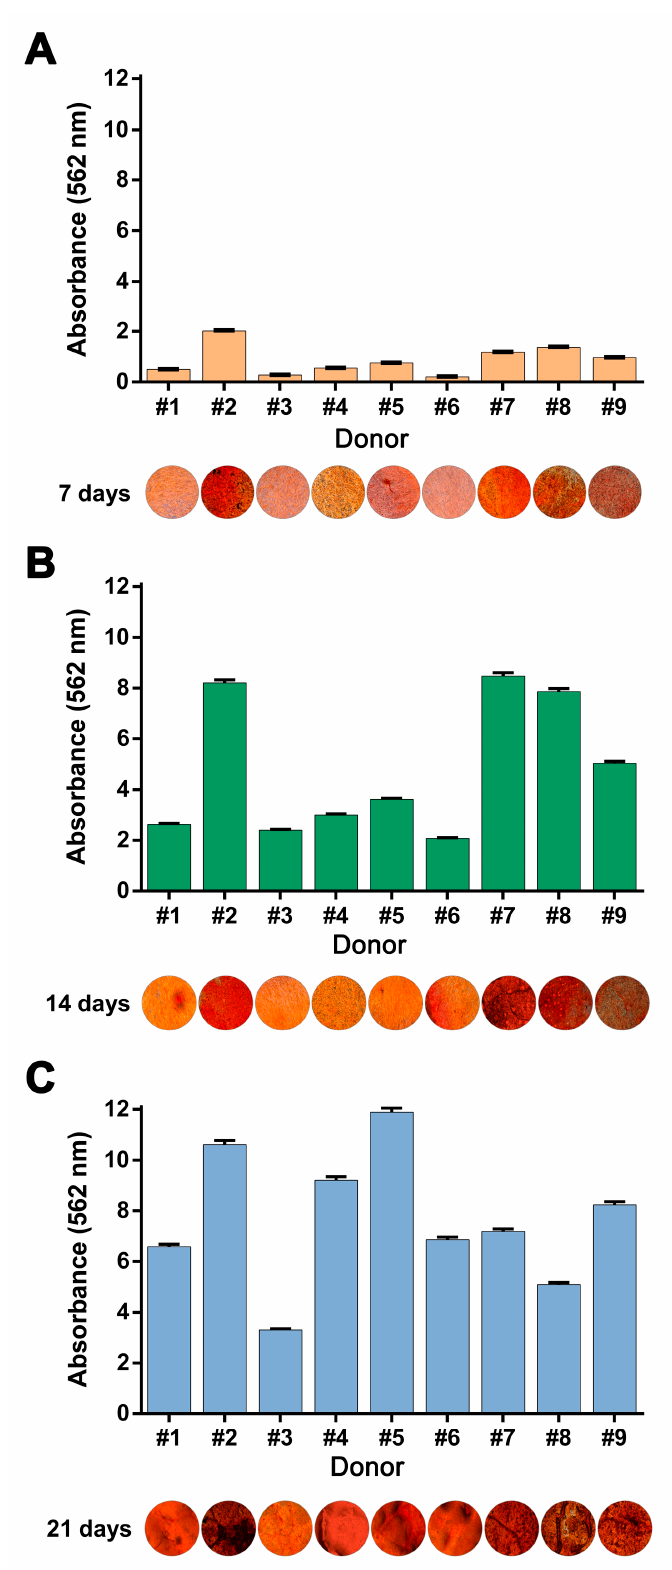
Figure 4. Inter-donor heterogeneity of quantified Alizarin red S staining of hMSC derived from donors #1–#9 treated with osteogenic medium for ( A ) 7, ( B ) 14 or ( C ) 21